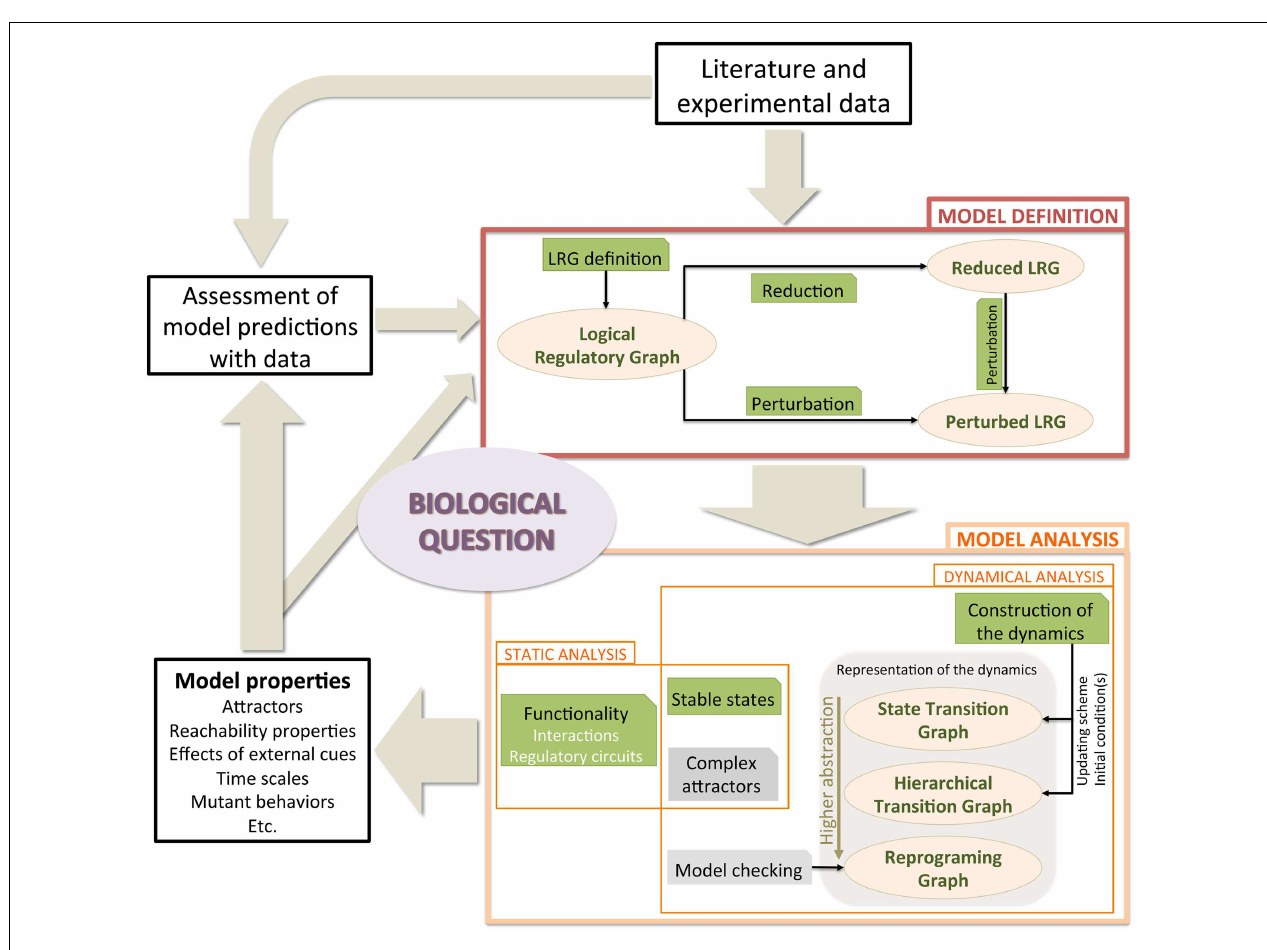
represented at different levels of abstraction, from the comprehensive state transition graphs to the reprograming graphs. Resulting properties are confronted with biological observations, leading to predictions and/or to model revision. Ellipsoid boxes relate to the different model versions and behavior representations. Green boxes denote methods that are available in GINsim, whereas gray boxes denote analyses performed with other software tools.